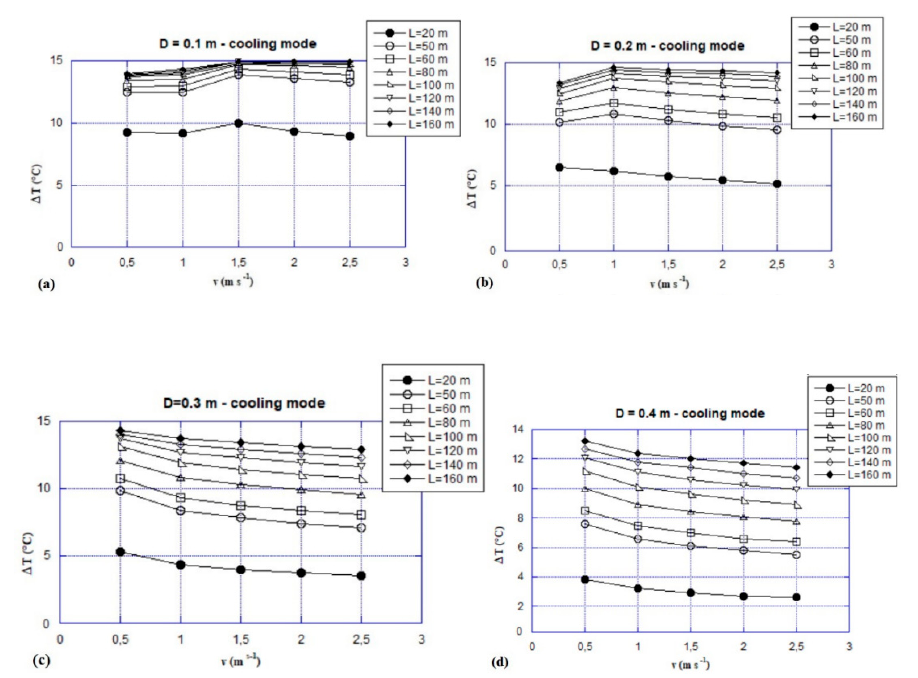
Figure 5. Inlet-outlet temperature span of the EAHX operating in cooling mode vs. air velocity, parametrized along the length for: ( a ) D = 0.1 m; ( b ) D = 0.2 m; ( c ) D = 0.3 m; ( d ) D = 0.4 m.